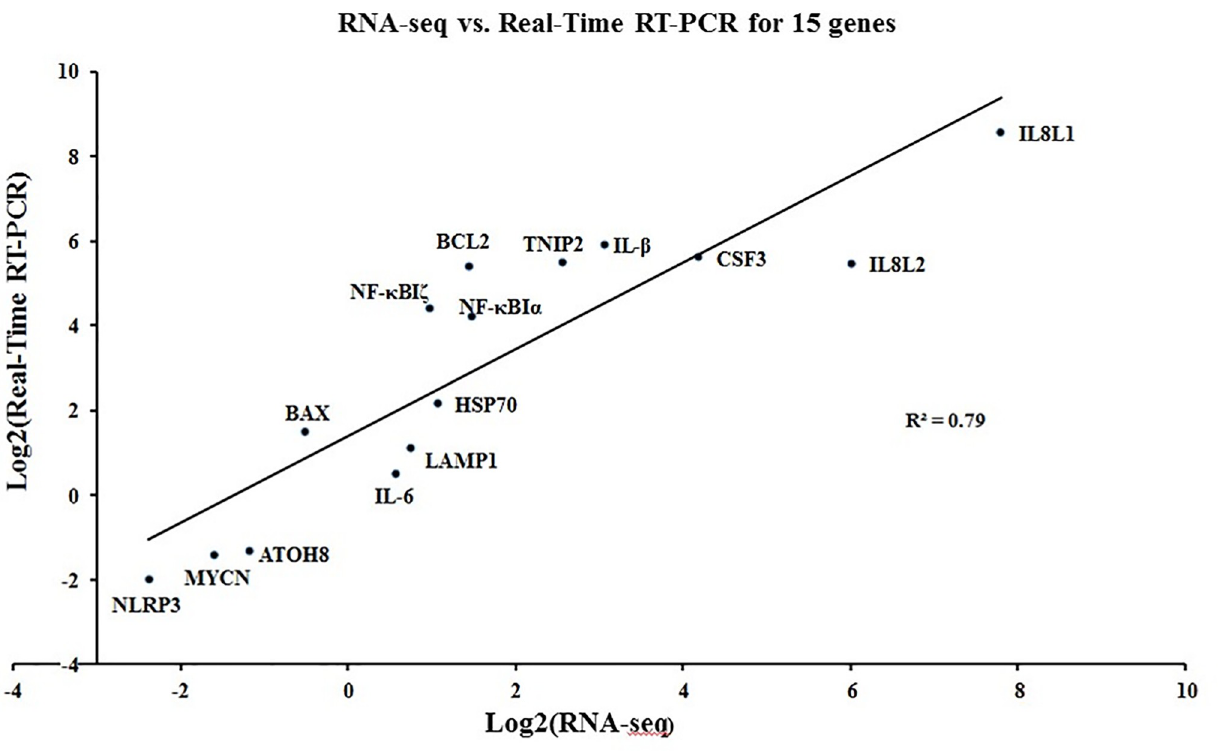
Fig 2. Correlation between RNA-seq and qRT-PCR data on 15 selected genes with various fold changes. Plotted by the logarithm of ratios of means between infected and uninfected samples. Primers are listed in S1 Table.